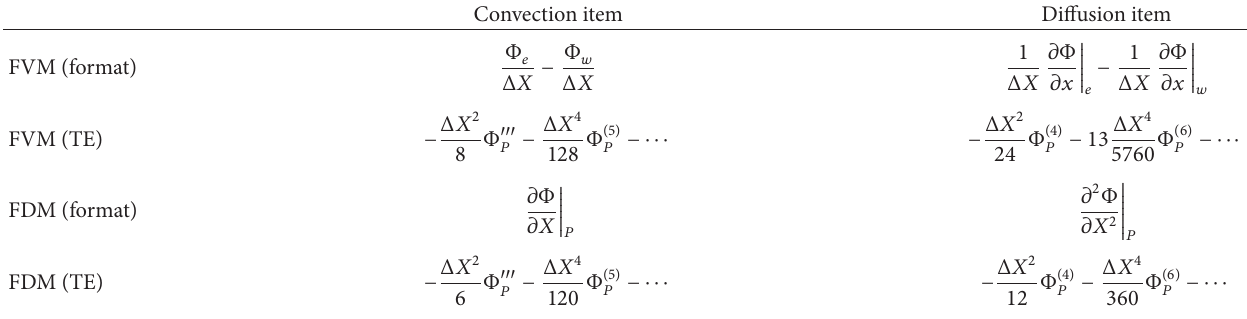
Table 4: Truncation error of FVM and FDM governing equations for vorticity-stream function algorithm of lid driven flow in a square cavity. Convection